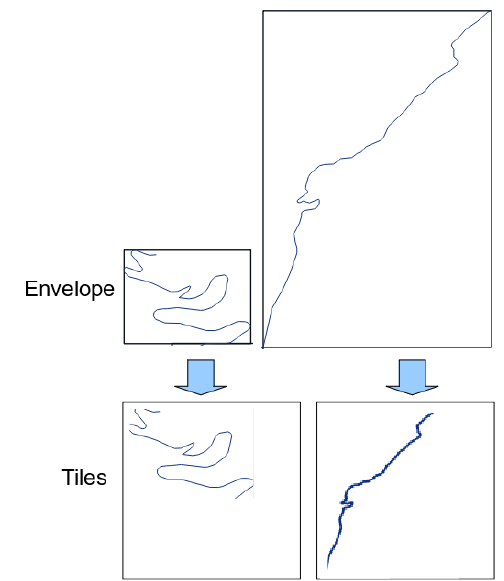
Figure 4. Illustration of the use of symbol width to mitigate the effect of varying scales with the object-based tiling method.